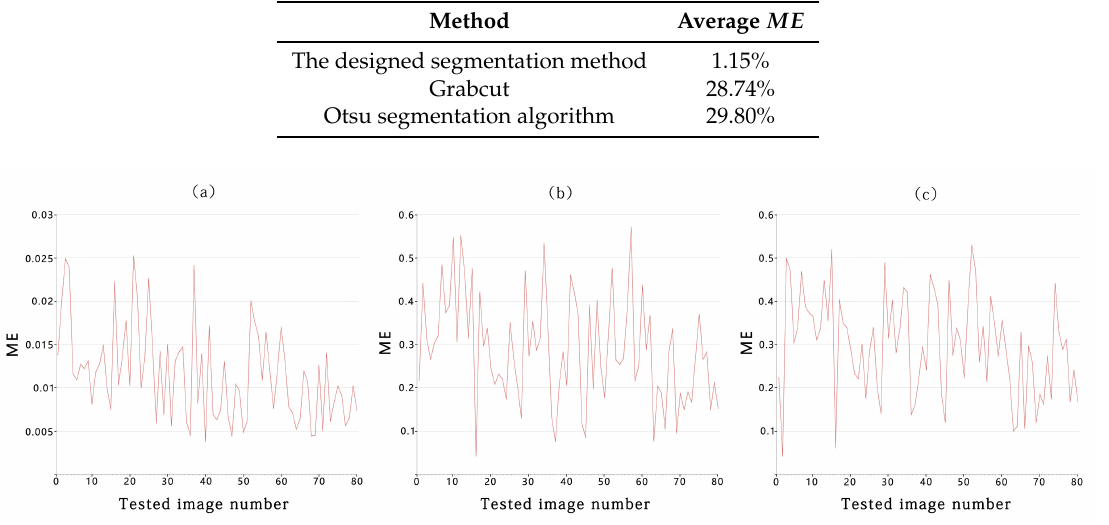
Table 1. The average Misclassification Error ( ME ) of different segmentation methods.